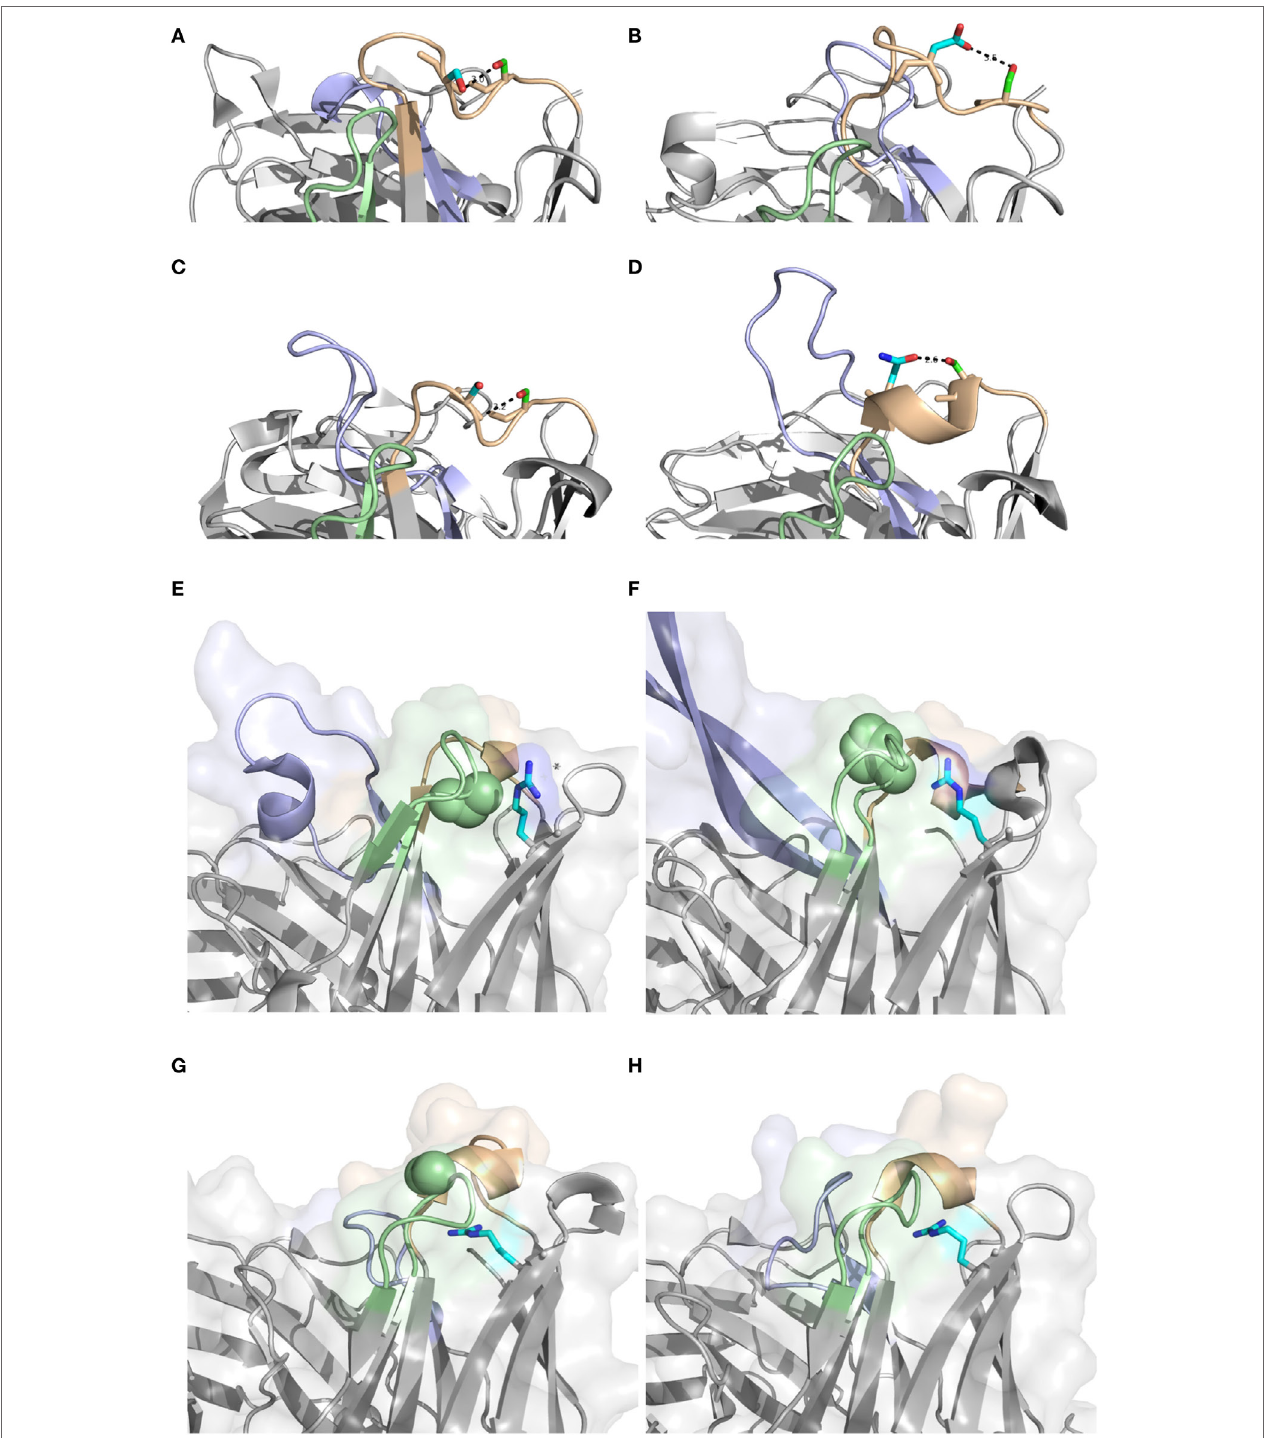
FigUre 14 | Position 29 of rearranged sequences of different germline gene origins are to different extents targeted by mutagenesis resulting in amino acid substitution ( Figure 3 ). A diversity of potential polar interactions of the side chain of S29 have been implicated such as those to O γ of S31 (IGHV2-5; PDB: 3QRG) (a) , O δ 2 of D31 (IGHV4-39; PDB: 5C6T) (b) , backbone O of S31 (IGHV4-59; PDB: 3HI1) (c) , and O δ 1 of N36 (IGHV5-51; PDB: 4BUH) (D) . H chain CDR1, CDR2, and CDR3, are colored in brown, green, and blue, respectively. Side chain atoms are colored in red (oxygen), blue (nitrogen), green (carbon of residue 29) and cyan (carbon of residue 31 or 36). Position of R80 (carbon of side chain shown in cyan) and residue 58 (residues of the side chain as spheres). Structures PDB: 3 × 3G (with P58) (e) and PDB: 3U1S (with H58) (F) both derived from IGHV1-8, and PDB: 3FZU (with S58) (g) and PDB: 2R56 (with G58) (h) , both derived from the IGHV3 subgroup, are shown. H chain CDR1, CDR2, and CDR3, are colored in brown, green, and blue,